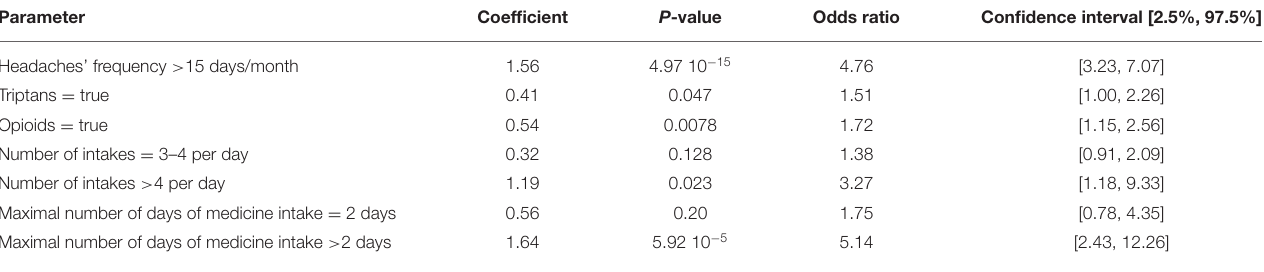
TABLE 3 | Odds ratios and confidence intervals of model’s